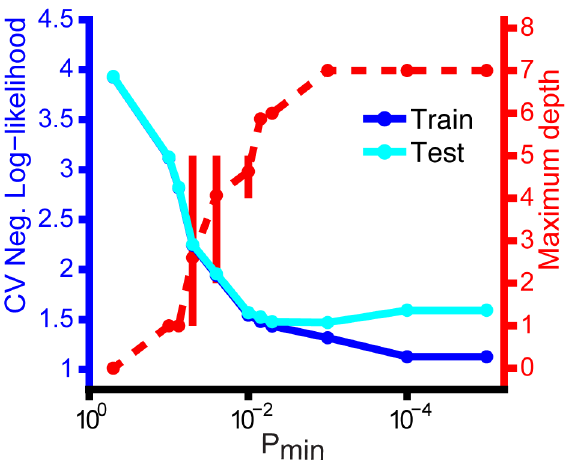
Figure 6. Cross-validation confirms that prediction suffix trees (PSTs) are not overfitting the data. PSTs were fit to 90% of the data and tested on the held-out 10% in a 10-fold cross-validation procedure for different values of p min , which sets the minimum frequency a sequence has to occur to be considered. If p min is too small, overfitting is guaranteed, and suffix trees will appear artificially deep. Shown is the performance of the PSTs for a single bird (PST is given in the bottom of Fig. 5 ). Using average negative log-likelihood to measure performance, the test performance peaks at p min ~ : 005 . Below this value the test performance begins to degrade and sharply diverges from training performance, a clear sign of overfitting.